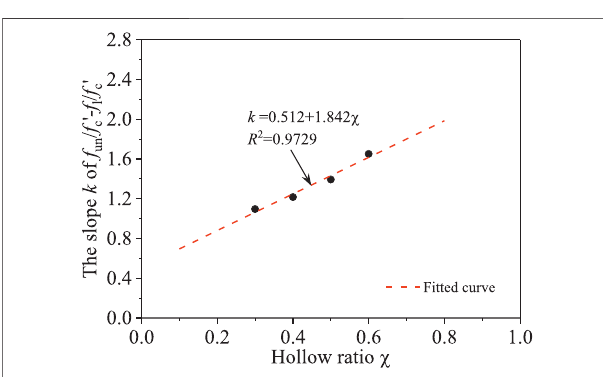
FIGURE 14 | Relationship between k and χ